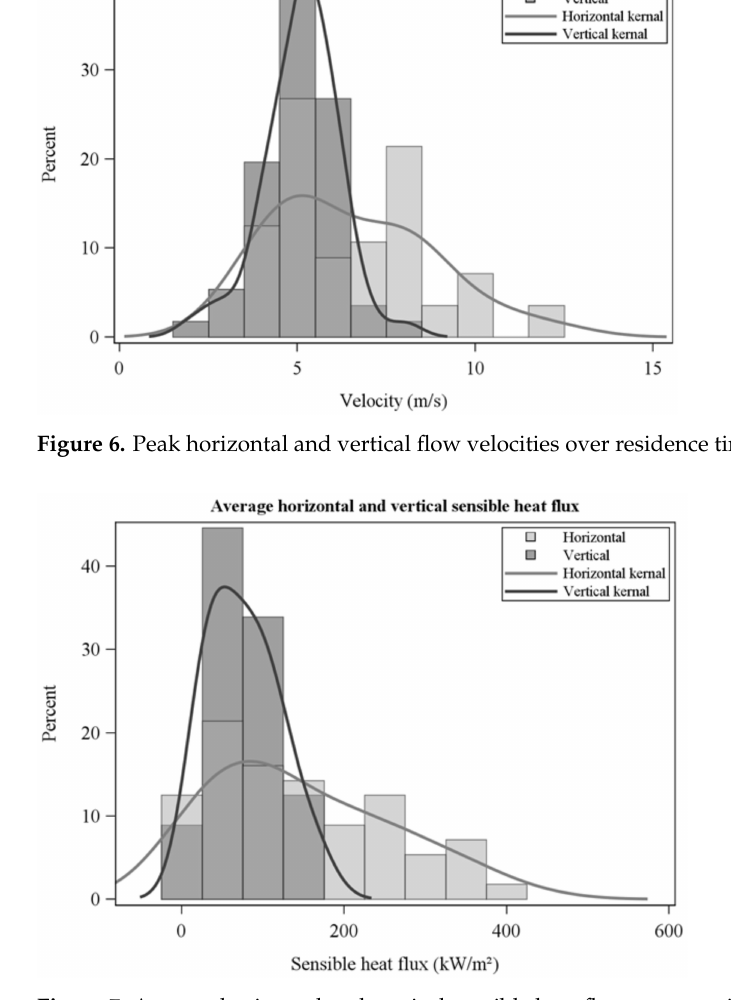
Figure 7. Average horizontal and vertical sensible heat fluxes over residence